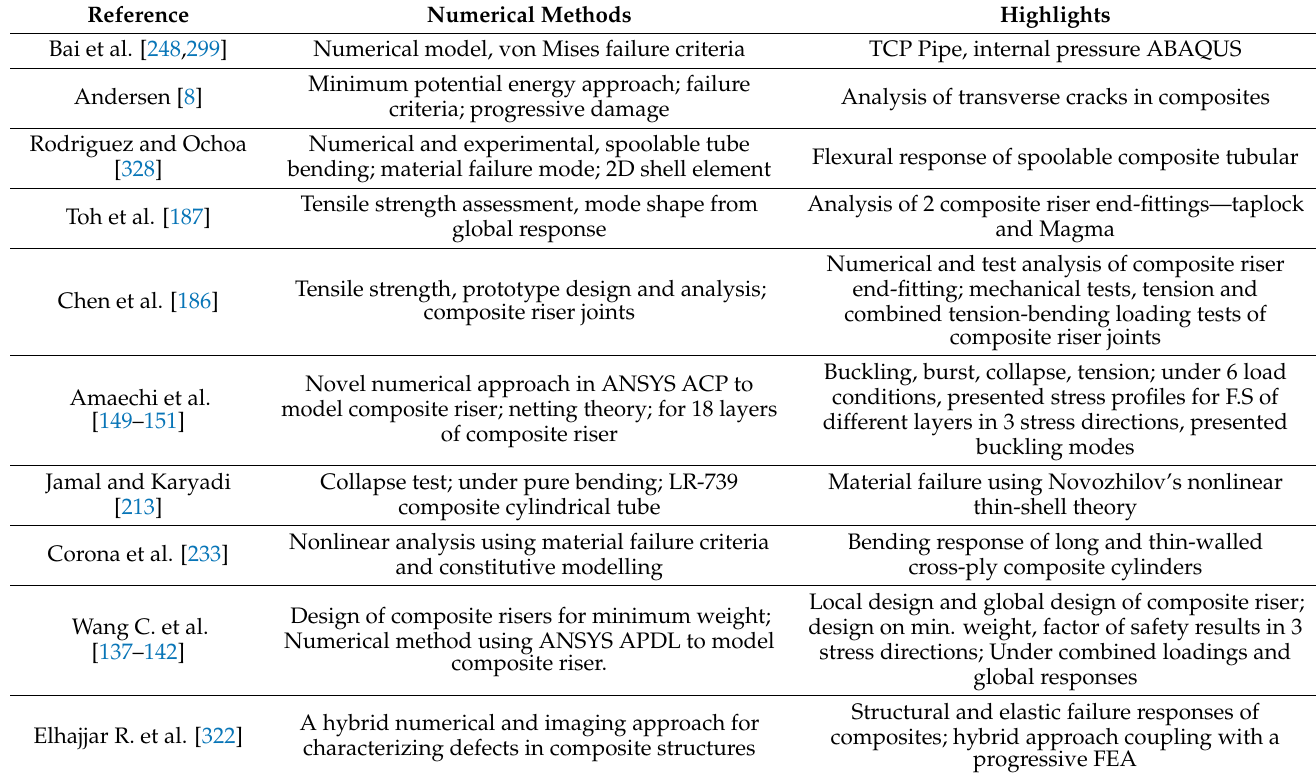
Table 7. Numerical analysis on composite risers, showing the test methods and mechanics